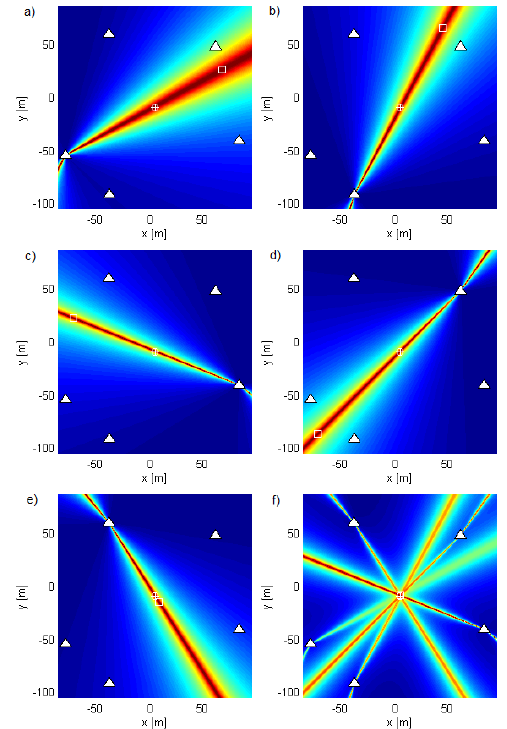
Figure 6. SCM-MUSIC criterion functions for f c = 4500 ( ν c = 900 MHz) and ν s = 200 kHz applied to ( a – e ) individual two-element subarrays in G 10 and ( f ) the sum of these